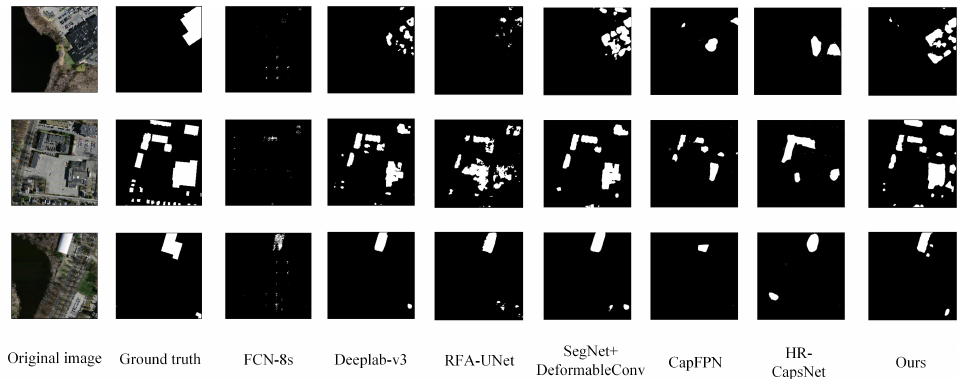
Figure 15. More visualization results about